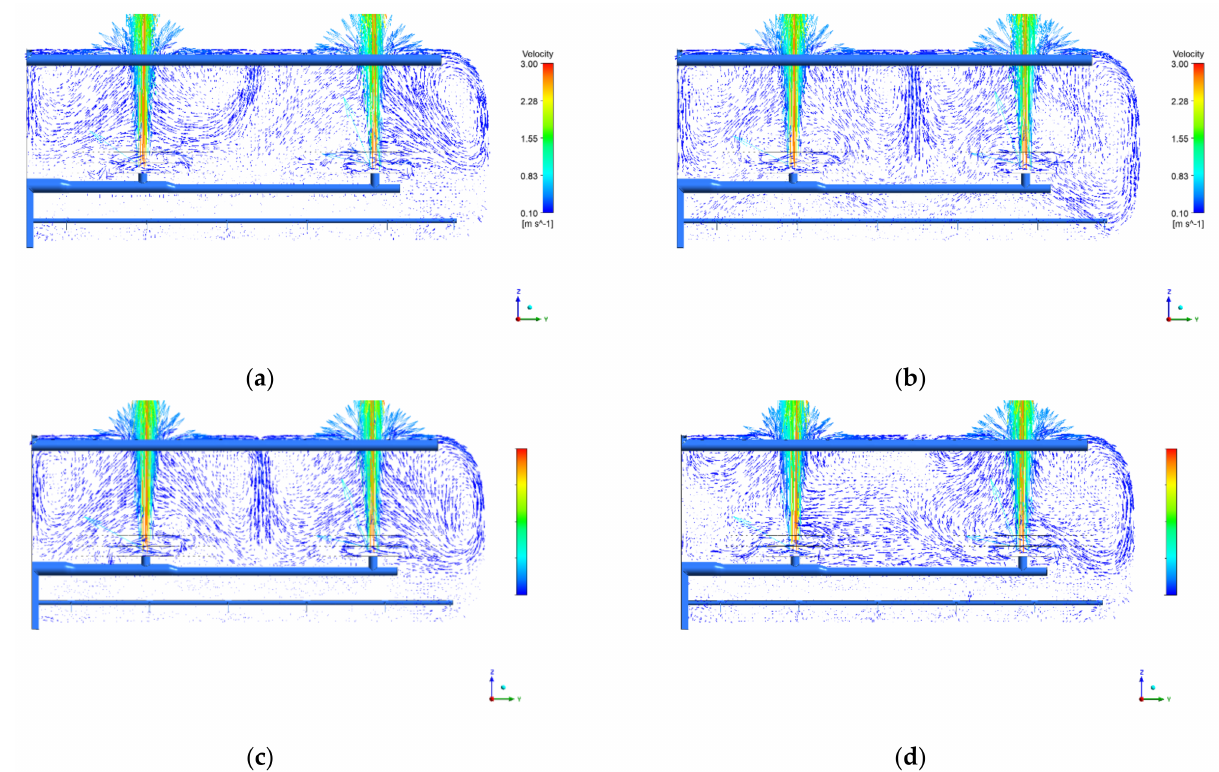
Figure 8. Effect of the water content on the velocity in a longitudinal plane for ( a ) high water content,